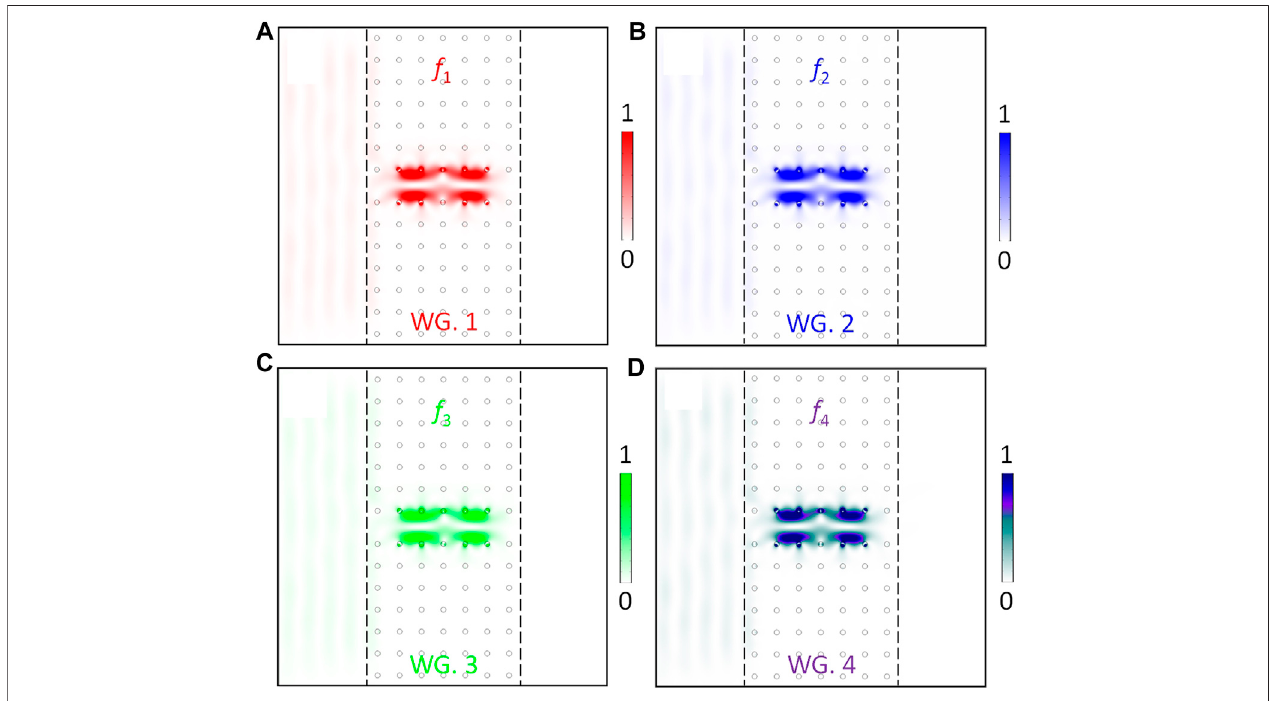
FIGURE5| Normalizedelectric fi elddistribution infour types ofslow lightwaveguide segments. (A) WG.1: f 1 (cid:1) 4.1902 GHz. (B) WG.2: f 2 (cid:1) 4.1614 GHz. (C) WG. 3: f 3 (cid:1) 4.1314 GHz. (D) WG. 4: f 4 (cid:1) 4.1032 GHz. The electric fi eld diagrams of frequencies f 1 , f 2 , f 3 , and f 4 are marked in red, blue, green, and purple,